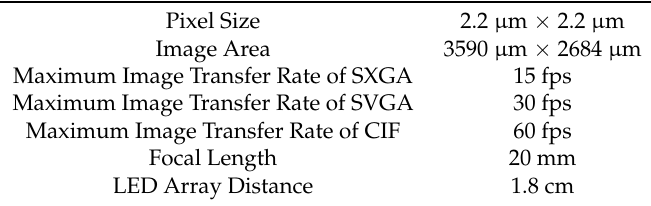
Figure 7. The experimental device for the MIMO-IS-VLC system. Table 2. Experimental device of related